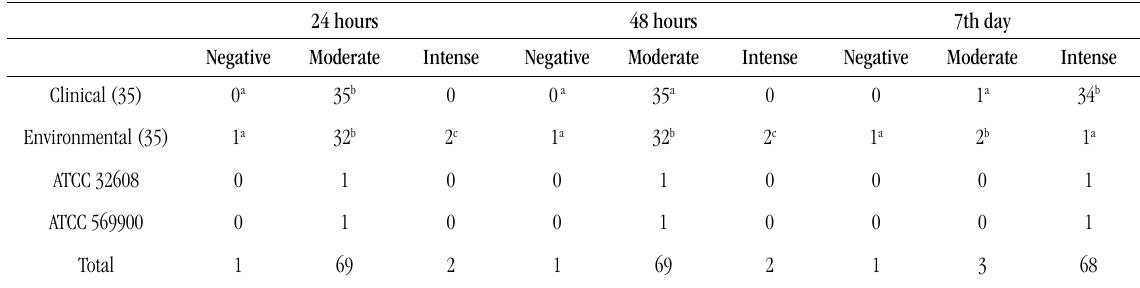
tABLE 6 – Urease production activity in clinical and environmental Cryptococcus neoformans and Cryptococcus gattii samples isolated in Sergipe, Brazil